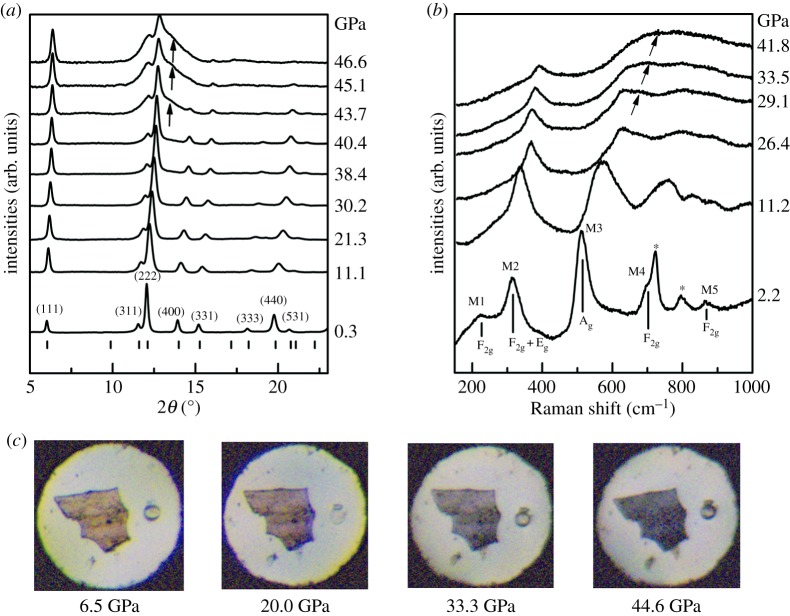
(a) The in situ synchrotron high-pressure XRD patterns of run 1. The arrow indicates that the new reflections belong to the Pnma cotunnite-like phase. (b) The in situ high-pressure Raman spectra of the Gd1.5Ce0.5Ti2O7. The star (*) mode belongs to the silicone oil, and the arrows indicate the new band observed at approximately 700 cm−1 when the pressure is higher than 29.1 GPa. (c) The sample's colour change under different pressures.